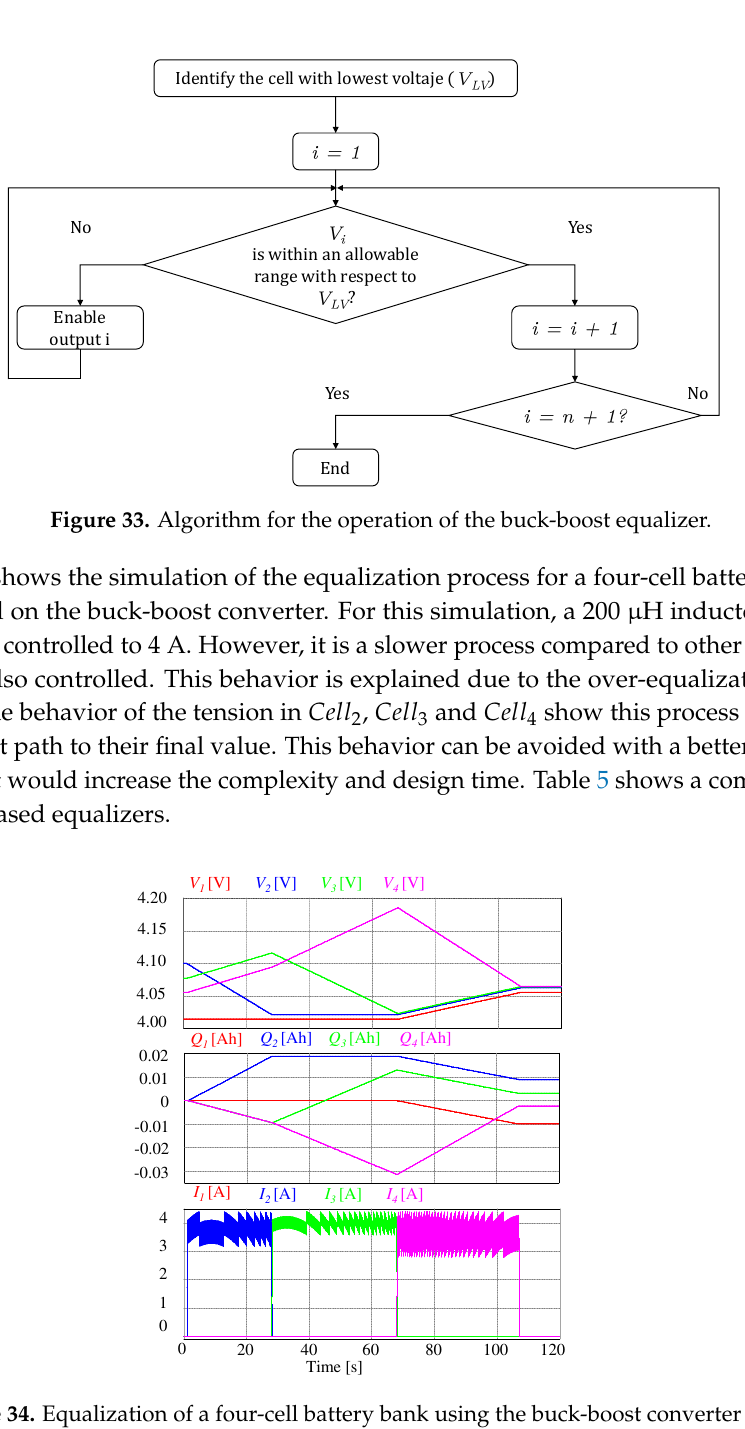
Figure 34. Equalization of a four-cell battery bank using the buck-boost converter